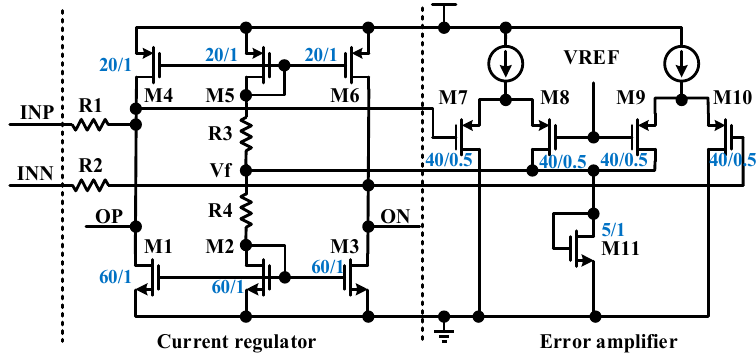
Figure 4. The input common mode voltage shifter.